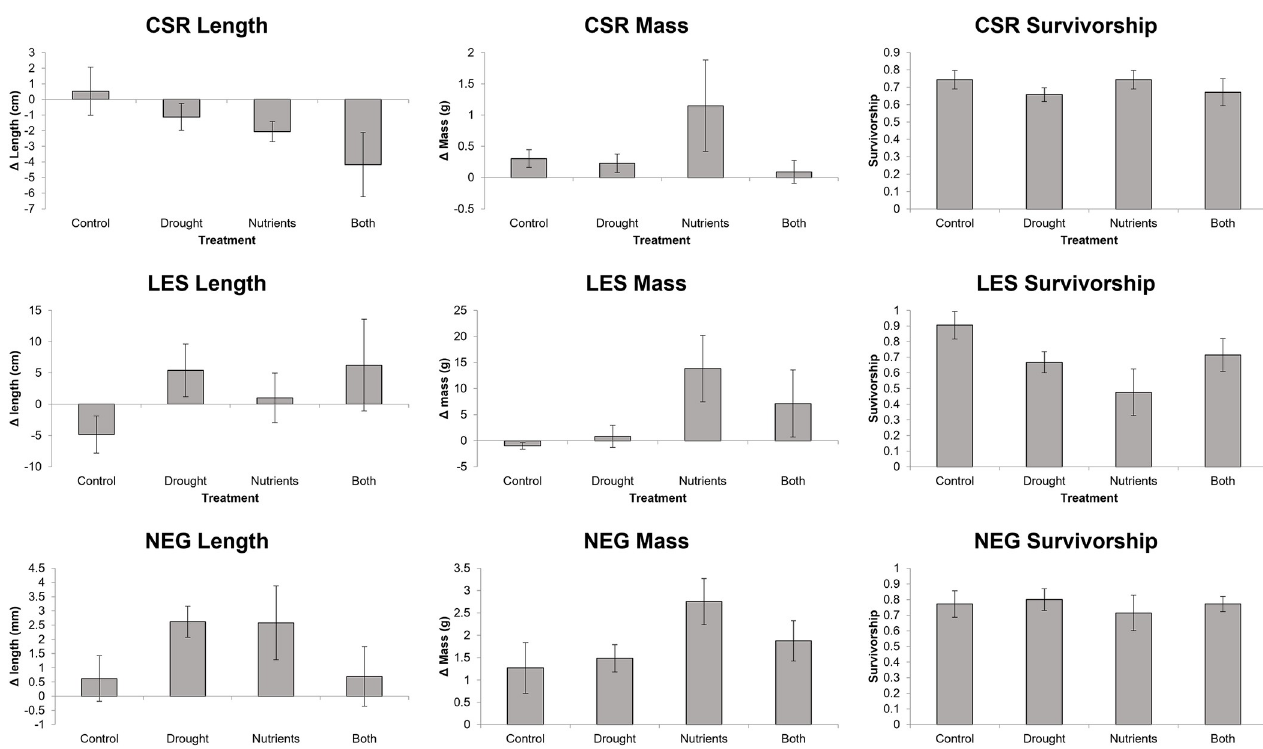
Fig 1. Change in length (left), mass (middle column), and survivorship (right) for Central Stonerollers (CSR, top), Longear Sunfish (LES, middle row) and Ringed Crayfish (NEG, bottom). Error bars are standard error.